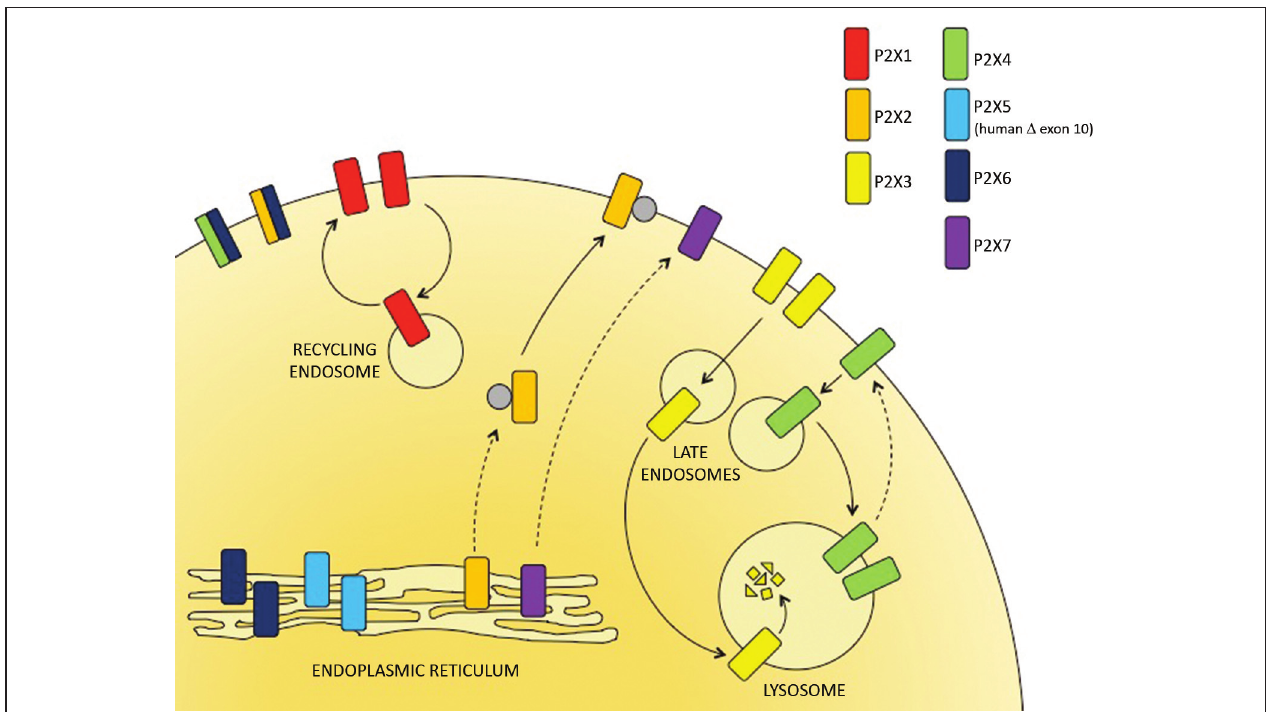
relatively slowly through the secretory pathway but are stably expressed at the surface. P2X1 receptors are expressed at the cell surface but rapidly cycle to and from recycling endosomes. P2X3 and P2X4 receptors are consitutively internalized and delivered to late endosomes and lysosomes. Within the lysosomes, P2X3 receptors are rapidly degraded but P2X4 receptors resist degradation and can recycle back to the